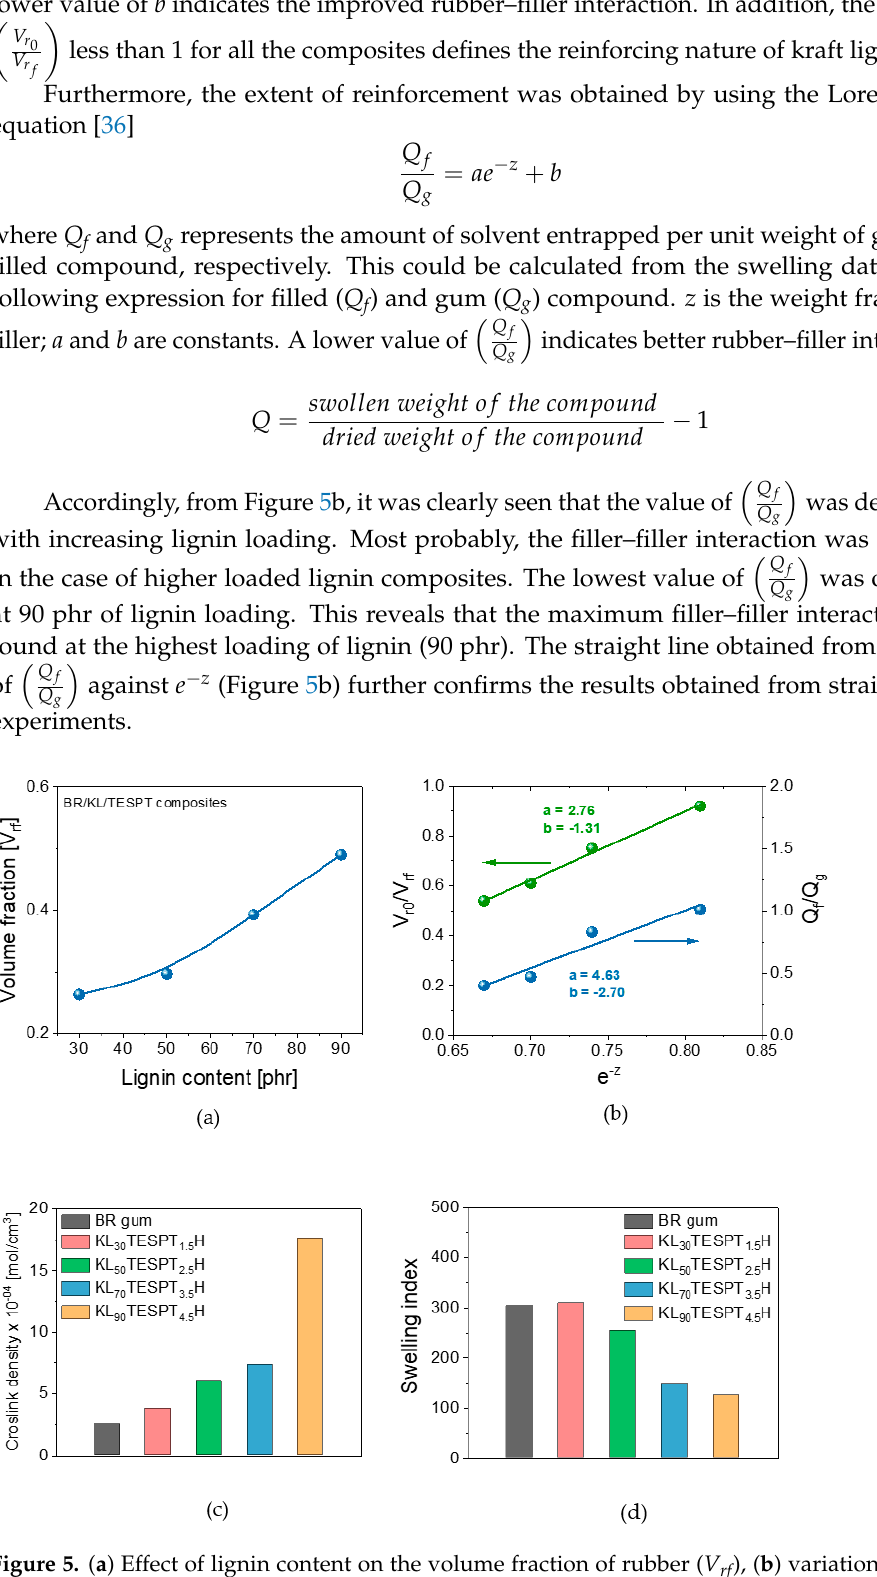
(cid:16) Q (cid:17) f with e − z (Lorenz–Park plot), ( c ) crosslink Q g